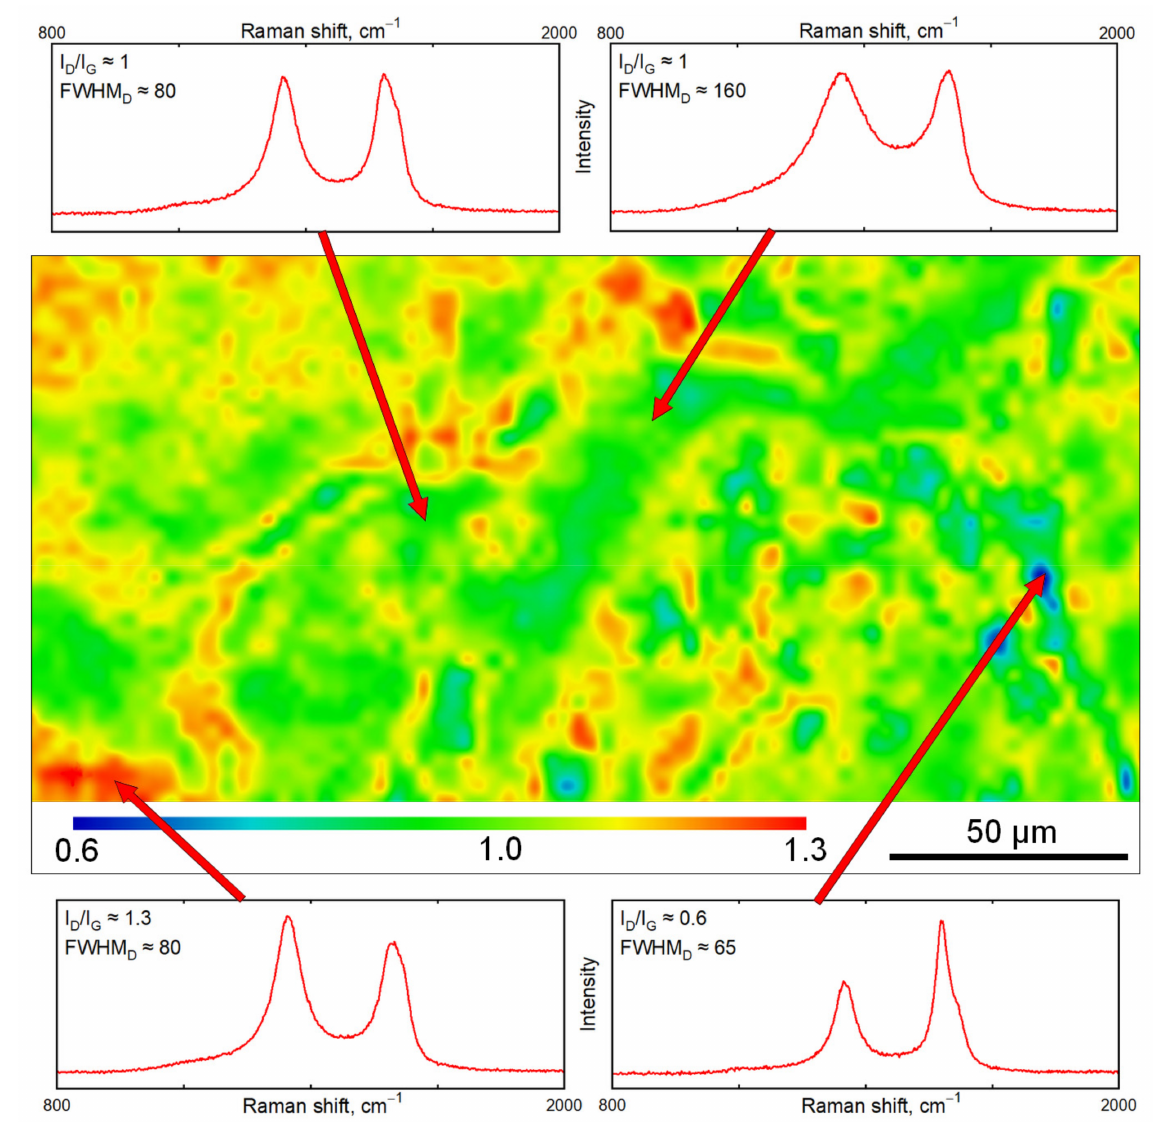
Figure 8. I D /I G contour map of carbon sample treated with excimer laser 4000 mJ · cm − 2 with selected type